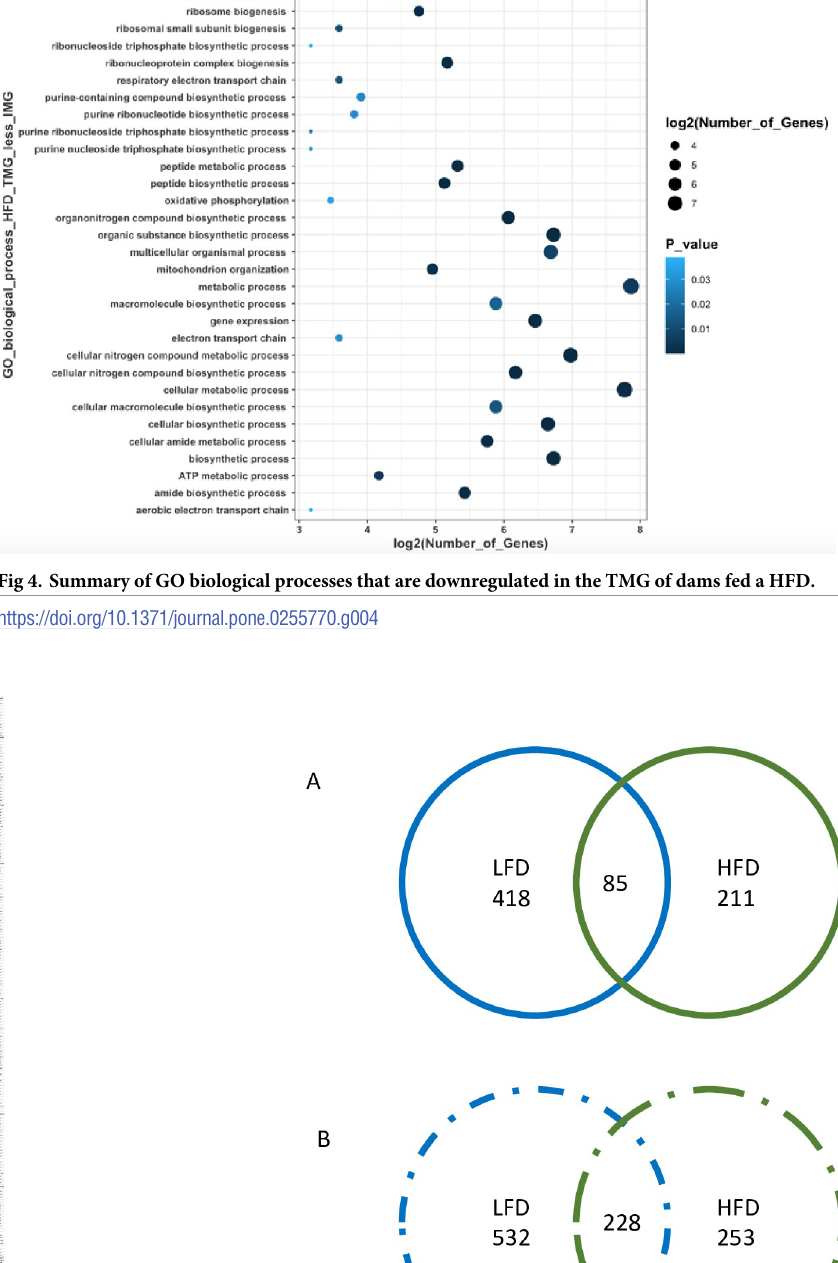
PLOS ONE | https://doi.org/10.1371/journal.pone.0255770 August 26,